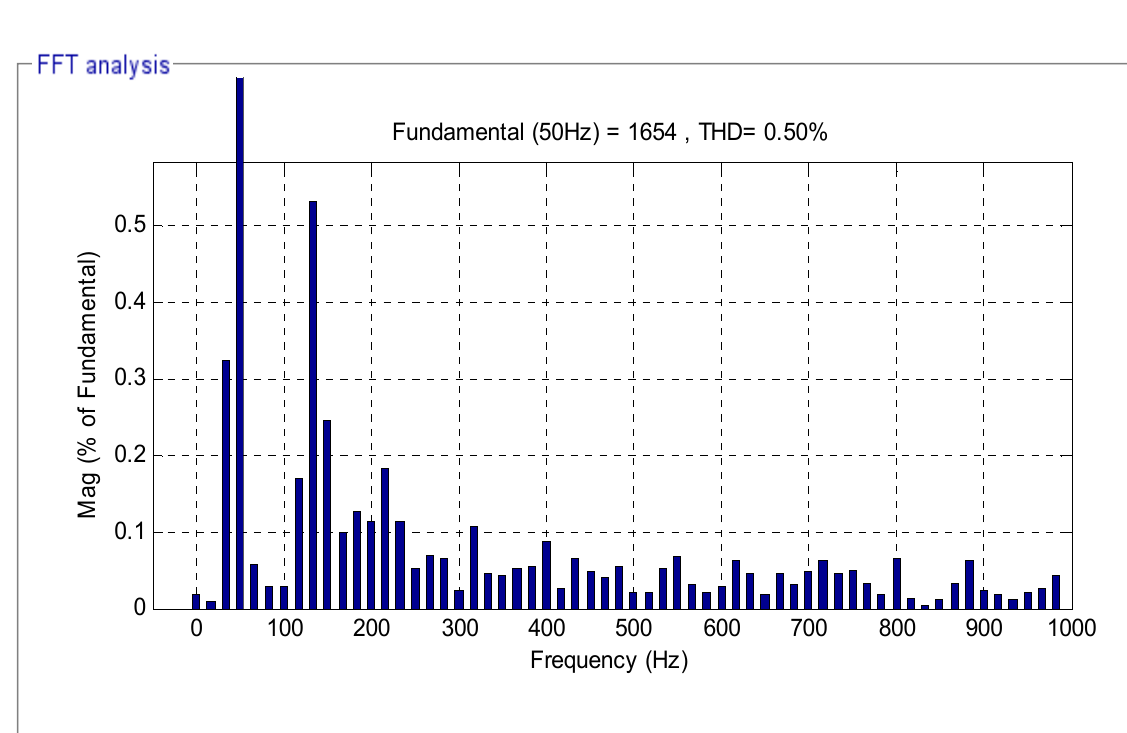
Figure 25. THD of current ( TSC-DARPC with NMSVM).